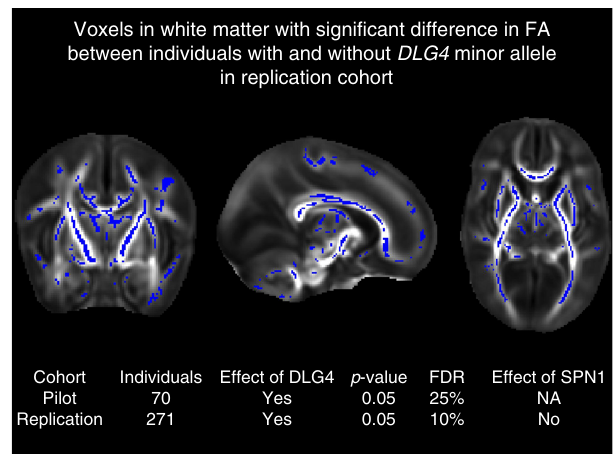
Fig. 6 3T d-MRI brain images for two cohorts of preterm infants acquired at term-equivalent age (Pilot: cohort 1, n = 70; Replication: cohort 2, n = 271). Images from replication analysis (cohort 2) shown. Views = sagittal, coronal, axial (left-right). Coloured voxels have signi fi cantly different diffusion features (fractional anisotropy, FA) between infants with or without the minor allele for DLG4 ( n = 271, threshold-free cluster enhancement (TFCE) p value < 0.05, FDR = 10% 81 ). Table inset : replication of fi ndings in two independent cohorts of preterm